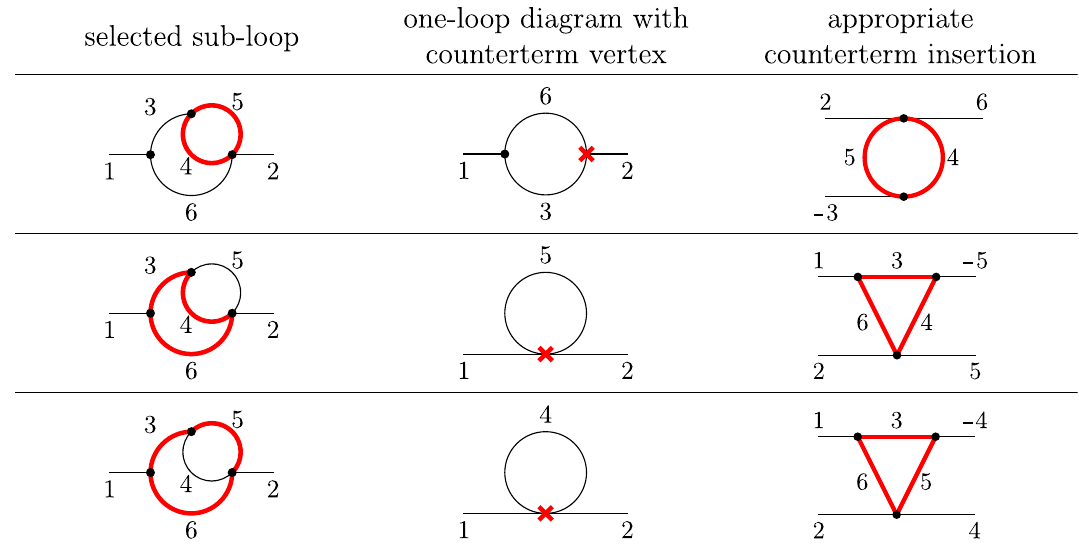
Fig. 3 The different sub-loops of topology 2 of the self-energies in Fig.2 are marked in red at the left column. After shrinking the lines of these sub-loops, the remaining one-loop diagrams with counterterm vertex are displayed at the middle column. The appropriate countert- erm insertion for each counterterm vertex is given at the right column.